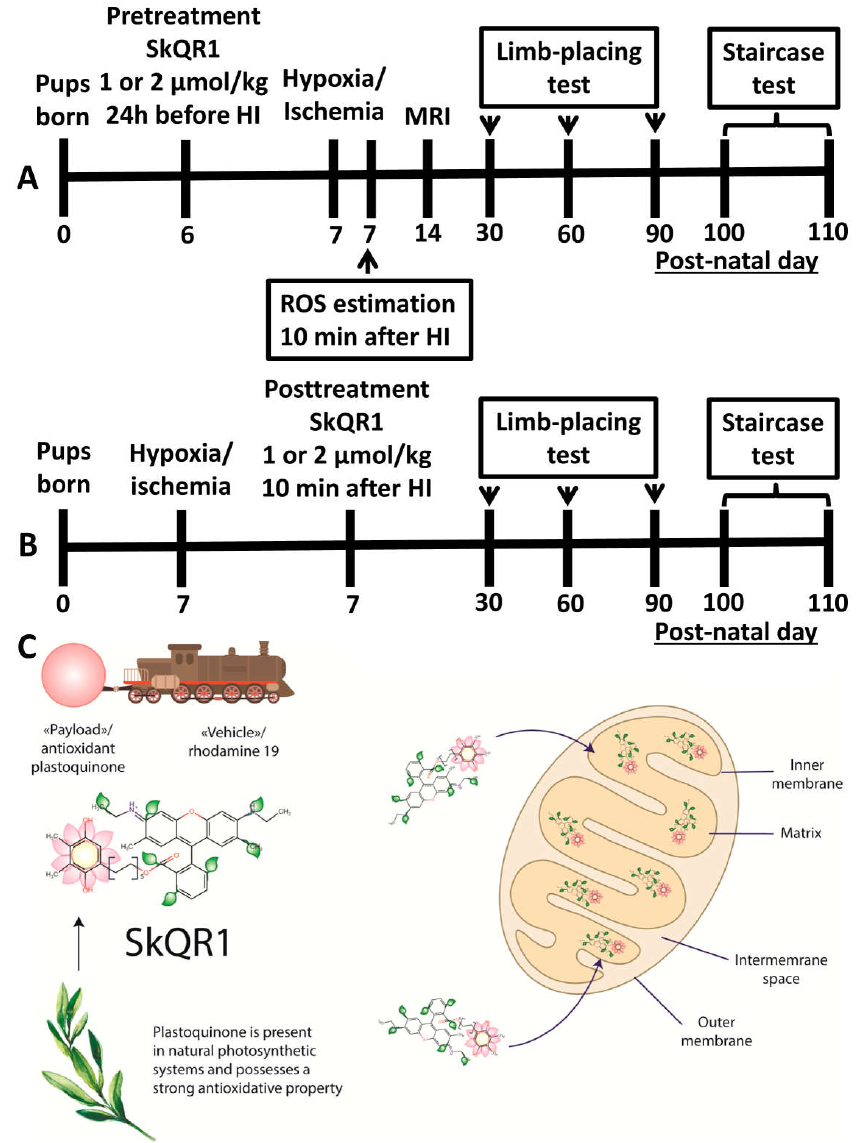
Figure 6. The study design. SkQR1 was administered intraperitoneally by two protocols: ( A ) The study pretreatment 24 h before HI or ( B ) posttreatment 10 min after reoxygenation onset at doses 1 or 2